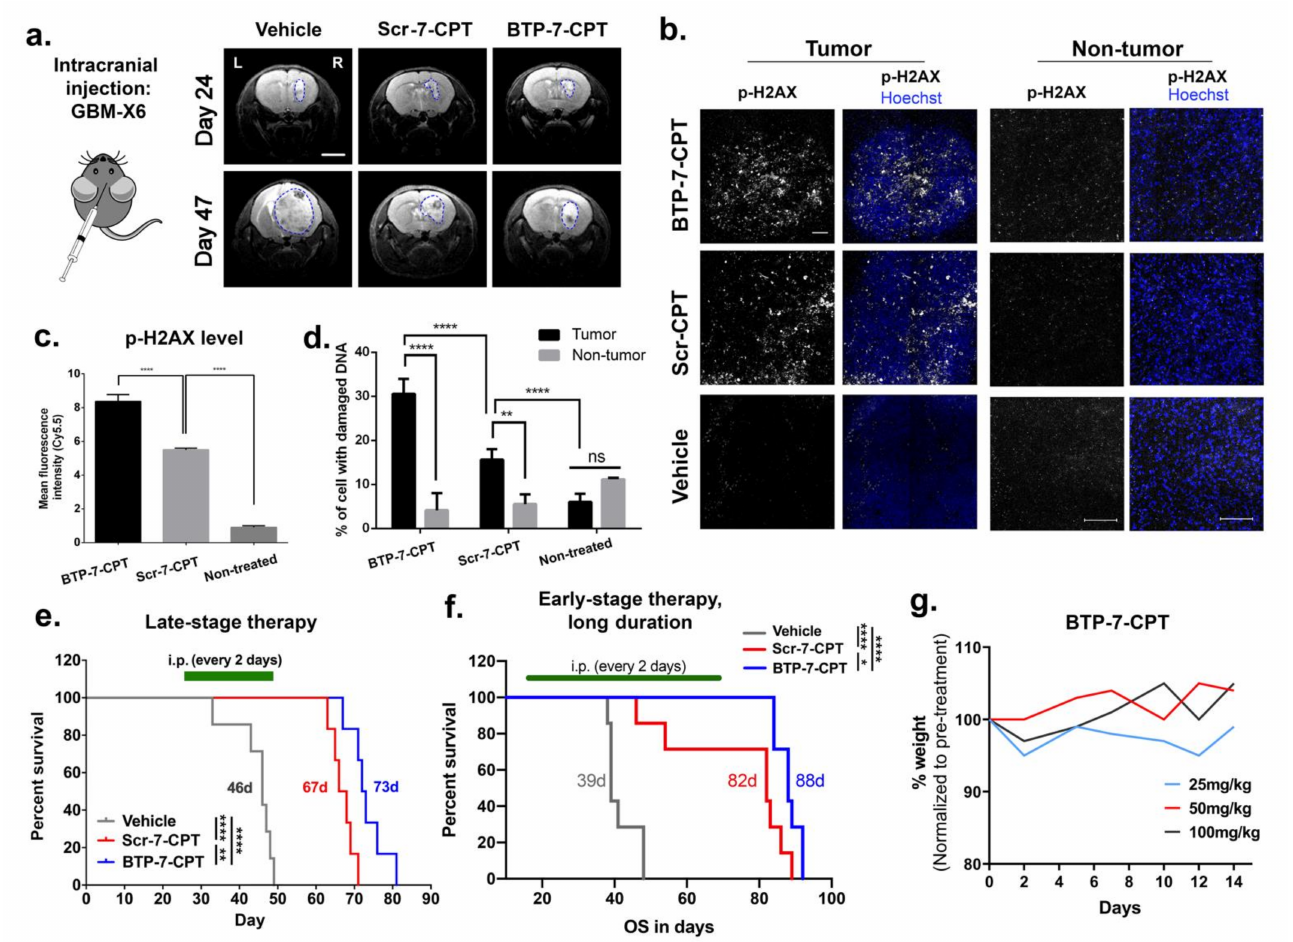
Figure 6. BTP-7 enhances drug delivery to GBM and prolongs survival in orthotopic PDX mouse model of GBM. ( a ) Representative MRI scans (coronal view) of mouse brain showing GBM-X6 (delineated with blue lines) after orthotopic xenotransplantation of patient-derived GBM-X6 cells in the right frontal lobe of the mouse brain at day 24 (before treatment) and day 47 (after treatment). Both the BTP-7-CPT and Scr-7-CPT groups showed reduced tumor burden compared to the control vehicle group. Scale bar: 2 mm. ( b – d ) Ex vivo analysis of brain cryo-sections from mice bearing GBM-X6 tumors after treatment. ( b ) Immunofluorescence staining for phospho-H2AX in tumor and non-tumor areas of mice brains harvested at day 49 after 13 treatments (nuclei stained with Hoechst dye (blue)). Scale bar: 100 microns. ( c ) Quantification of phospho-H2AX signal within the tumor areas shown in ( b ) ( n = 3, one-way ANOVA and Tukey’s multiple comparisons test). ( d ) Quantification of the number of nuclei positive for phospho-H2AX signal in the tumor and non-tumor tissues of ( b ) ( n = 3, two-way ANOVA and Sidak’s multiple comparison test (* p < 0.05, ** p < 0.01, **** p < 0.0001). ( e , f ) Kaplan–Meier survival plot of mice bearing GBM-X6 tumors that received ( e ) late-stage treatment (i.p.; 10 mg/kg dose starting at Day 25 to 49 post tumor implantation) or ( f ) early-stage and longer treatment duration (i.p.; 10 mg/kg dose starting from day 18 to day 68 post tumor implantation) with BTP-7-CPT (blue), Scr-7-CPT (red), or vehicle (gray). Treatment was performed every 2 days. In both studies, a significant difference (late-stage p < 0.0092; early-stage p < 0.022) is observed between the BTP-7-CPT and Scr-7-CPT treatment group, as well as between the drug conjugate and vehicle group ( p < 0.0001) as determined by the Log-rank (Mantel–Cox) test (* p < 0.05, ** p < 0.01, **** p < 0.0001). ( g ) Graph showing the weights of the mice treated with BTP-7-CPT at 25, 50, and 100 mg/kg, indicating no decline in weight over more than 2